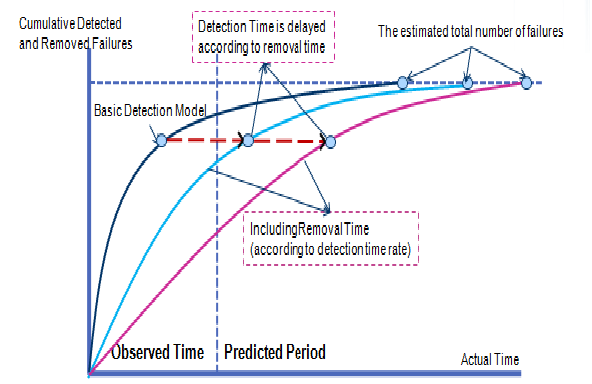
Fig. 4. Results of the Basic Exponential Model and the Proposed